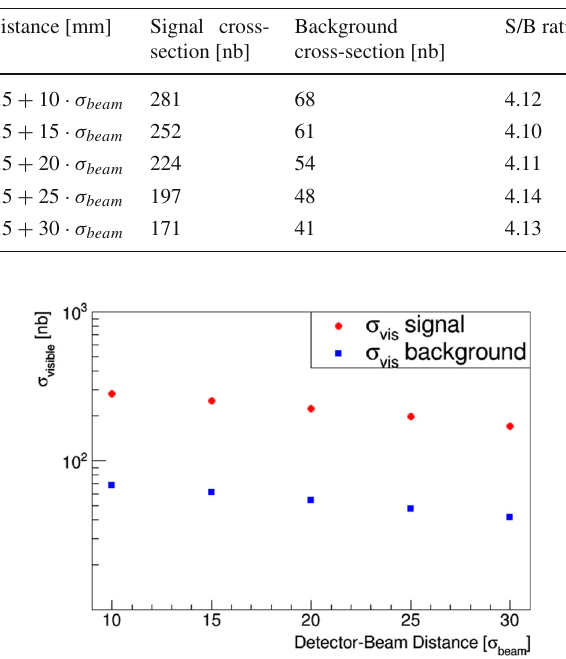
Table 4 The visible cross-sections in nb for the signal and background for different distances of the detector active part and the beam for R p = 0 . 5 mm and β ∗ = 90 m